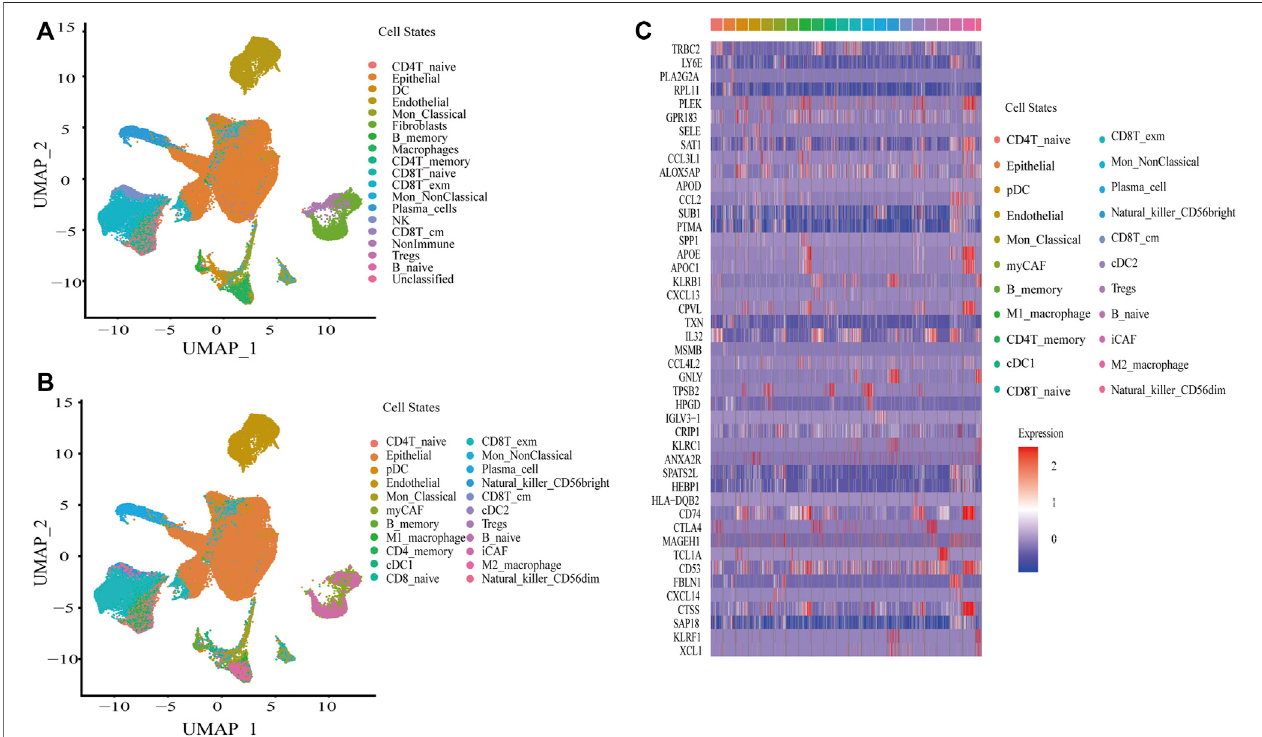
FIGURE1 | Construction ofa single-cell atlas inBC. (A) UAMP plot ofa single cell atlas ofBC in fi rst identi fi cation by Signacx. (B) UAMP plot ofa single cell atlas of BC in subclustering. (C) Heatmap plot of the top two markers of cell states in BC.